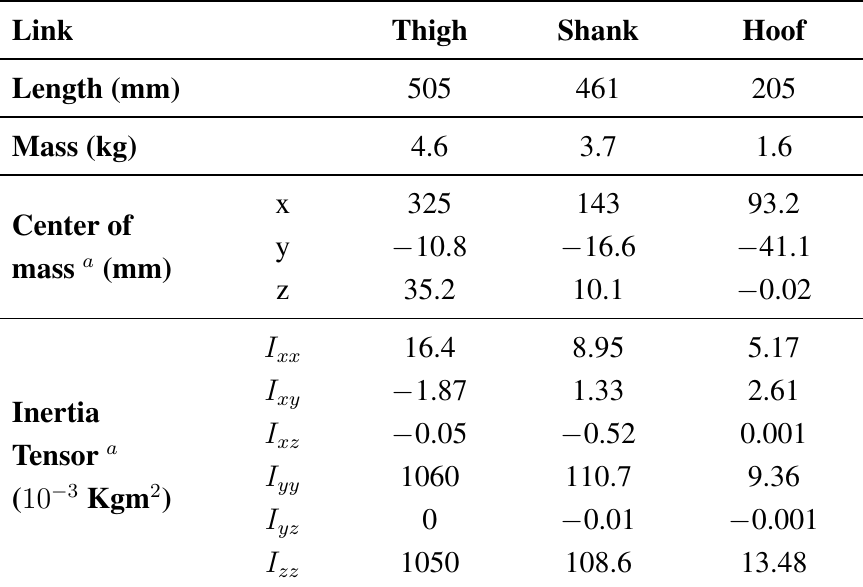
Table 7. Physical parameters of the HADE leg